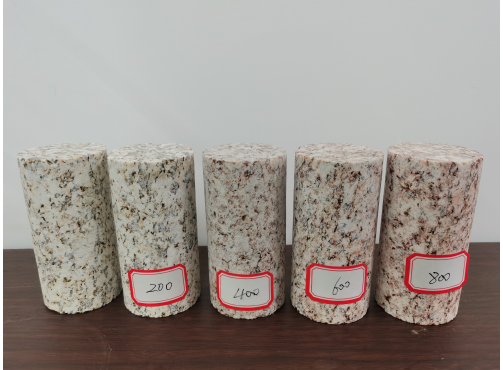
Figure 2. Heat-treated granite